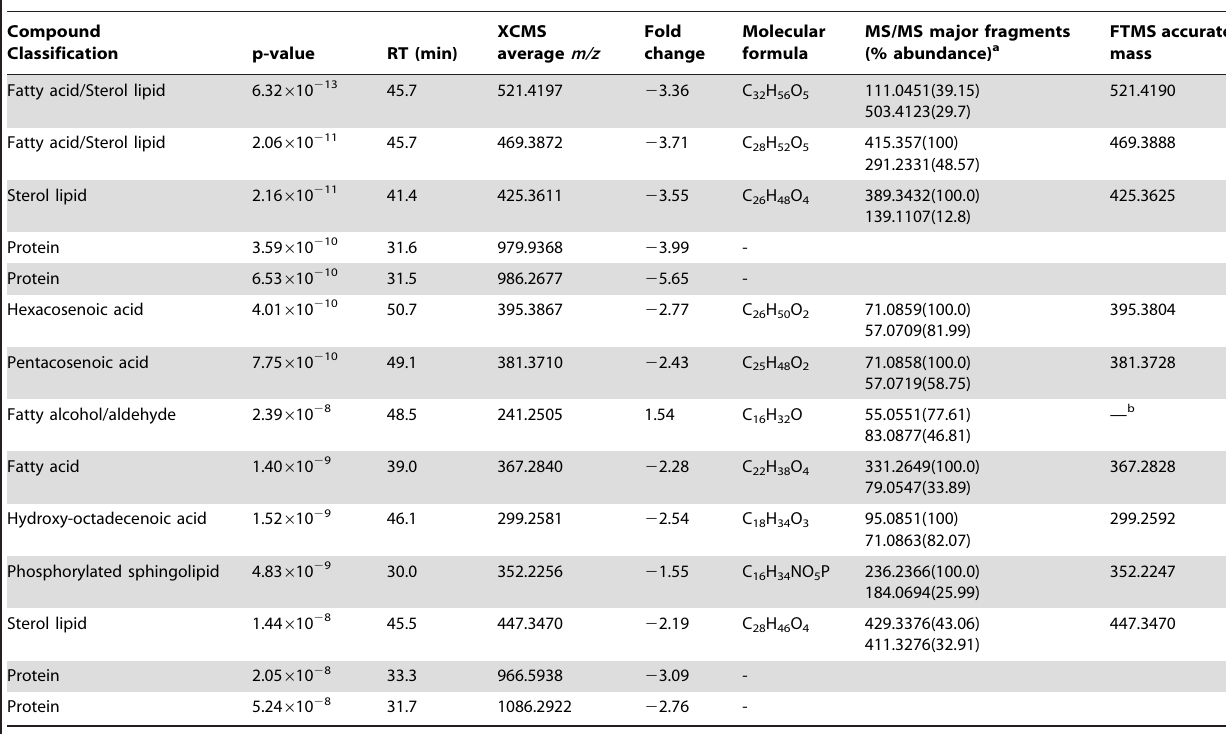
Table 2. Characteristics of the 14 candidate